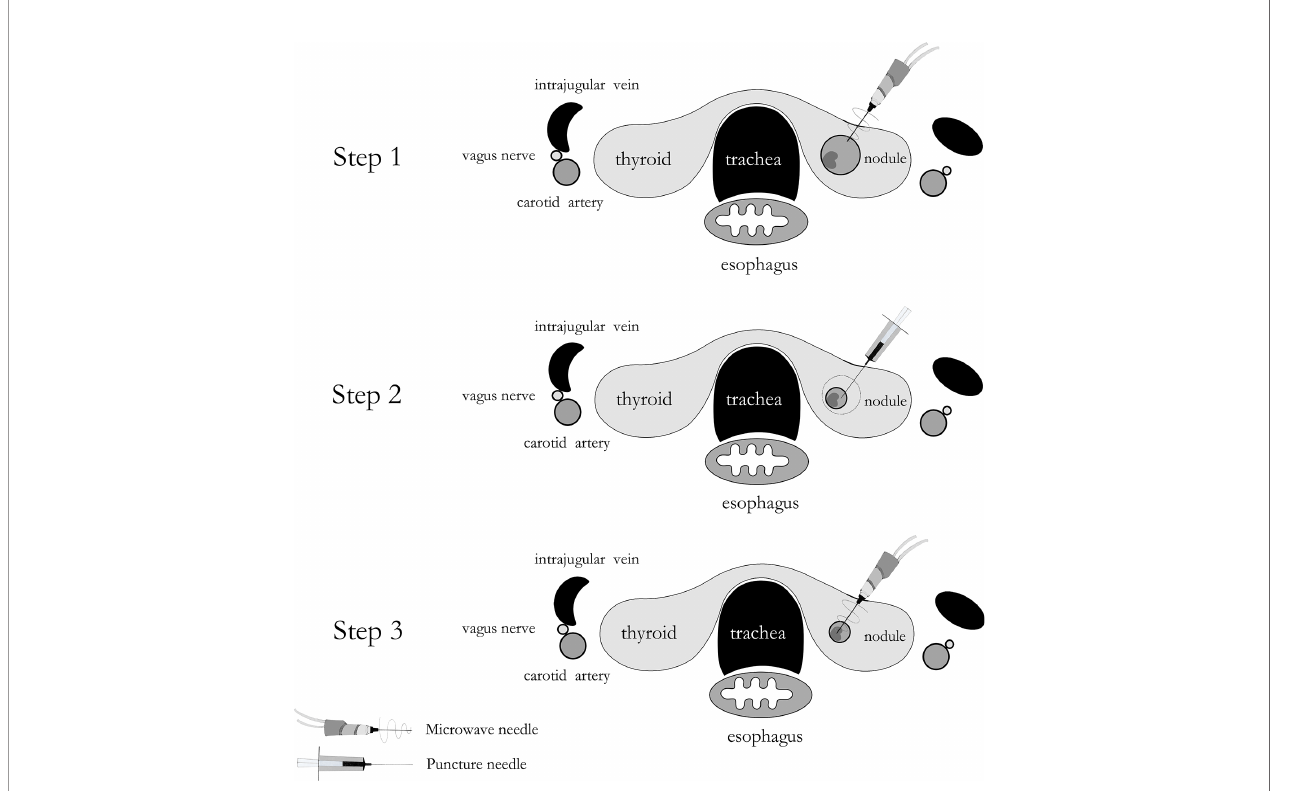
FIGURE 2 | A schematic drawing of ablating aspiration needle tract before microwave ablation for predominantly cystic thyroid